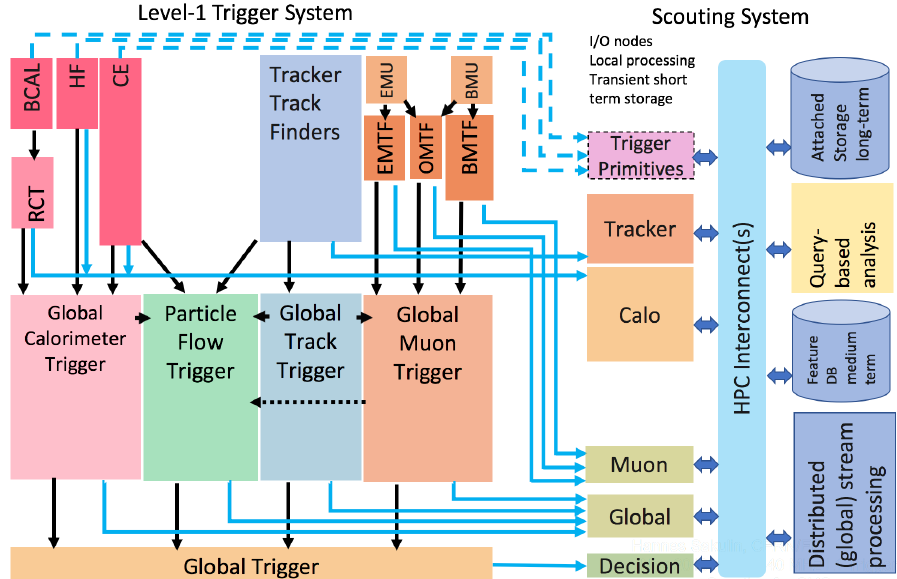
Fig. 1. The CMS Level-1 trigger system for Phase-2 (left) and the proposed Scouting System (right). BCAL: Barrel Calorimeter; HF: Hadronic Calorimeter Forward; CE: Calorimeter Endcap (high granularity); RCT: Regional Calorimeter Trigger; EMU/BMU: Endcap/Barrel Muon System; EMTF/OMTF/BMTF: Endcap / Overlap / Barrel Muon Track Finder.